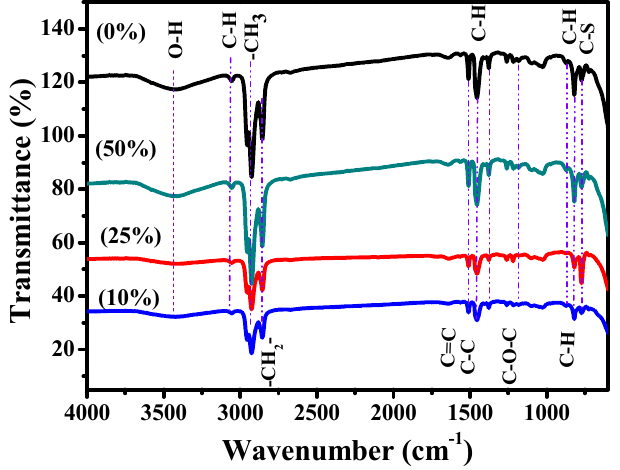
Figure 1. FTIR spectra of P3HT, and P3HT/50% SWCNTs, P3HT/25% SWCNTs and P3HT/10% SWCNTs